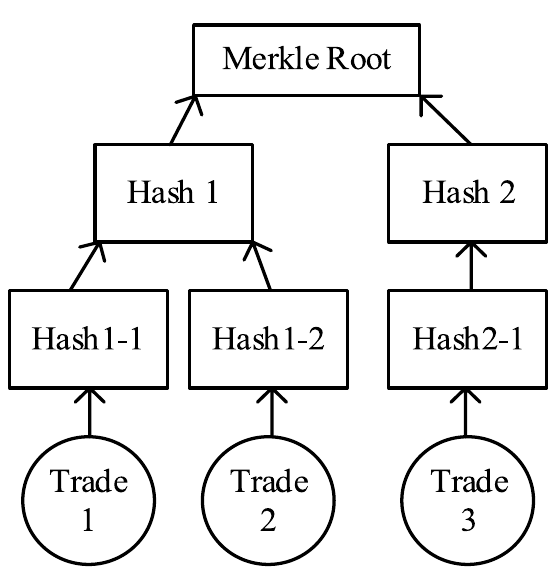
Fig. 3 Schematic diagram of Merkle tree